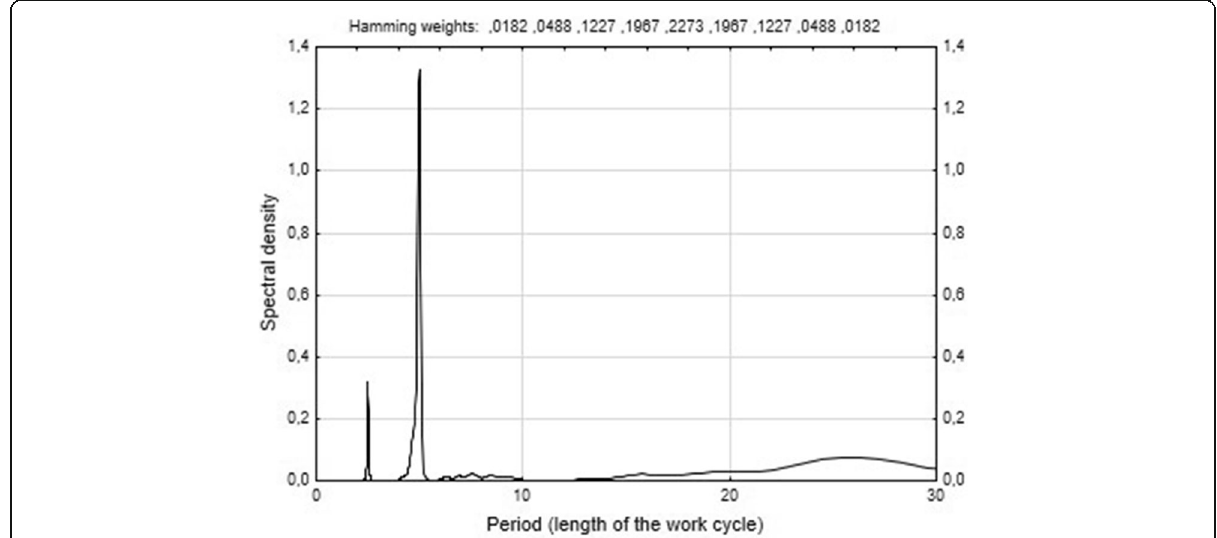
Fig. 4 Fragment of a periodogram of a harvester operating in thinned